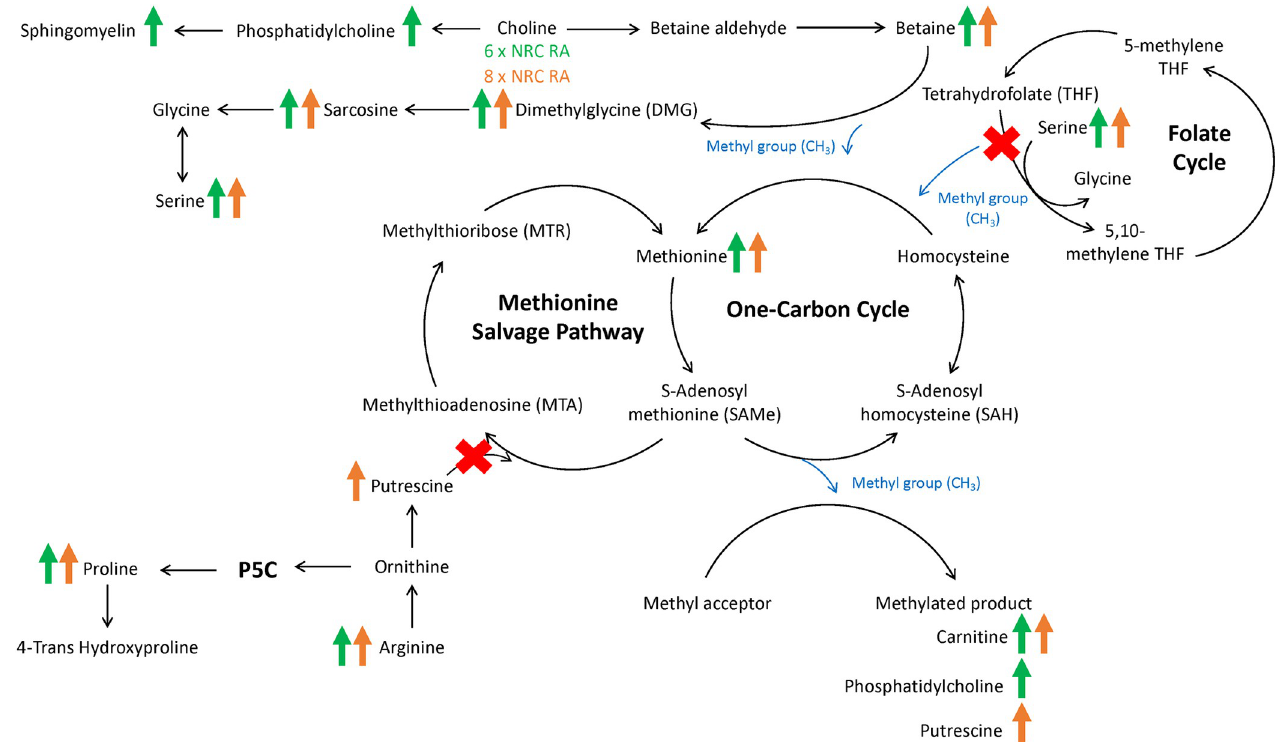
Fig 3. Changes in mean serum metabolite concentrations in overweight male adult cats (n = 14) resulting from the consumption of dietary choline at 6 x NRC RA (378 mg/kg BW0.67) or 8 x NRC RA (504 mg/kg BW0.67) for 3-week periods. Green and orange arrows represent increased serum metabolite concentrations with 6 x NRC RA or 8 x NRC RA, respectively. A red “X” represents a hypothesized decreased activity of said pathway.